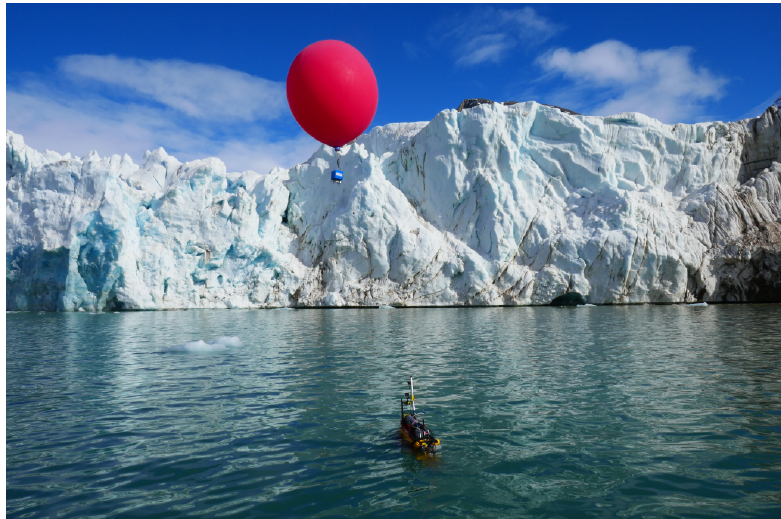
Figure 1. PROTEUS (Portable RObotic TEchnology for Unmanned Surveys) vehicle with atmospheric sensors in the 2018 campaign carried out by CNR-INM in